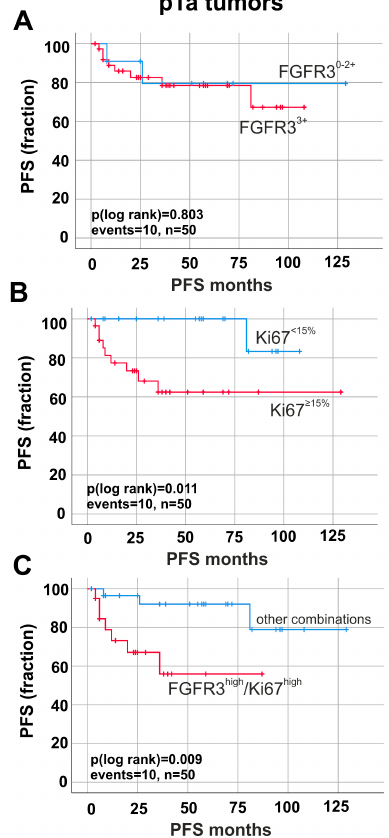
Figure 3. Prognostic impact of FGFR3 and Ki67 protein expression in papillary non-invasive (pTa) tumors. Kaplan–Meier survival curves demonstrate progression-free survival (PFS). ( A ) Survival curves of patients with high FGFR3 expression (red curve, n = 39) compared to low FGFR3 expression (blue curve, n = 11). ( B ) Kaplan–Meier analysis of patients with high Ki67 expression (red curve, n = 28) compared to low Ki67 expression (blue curve, n = 22). ( C ) Impact of combined markers on risk stratification of tumor progression is shown. Survival curve analysis of FGFR3 high /Ki67 high expression (red curve, n = 20) compared to all other combinations of FGFR3 and Ki67 expression (blue curve, n = 30) in pTa tumors. n, overall number of cases; events, overall events of tumor